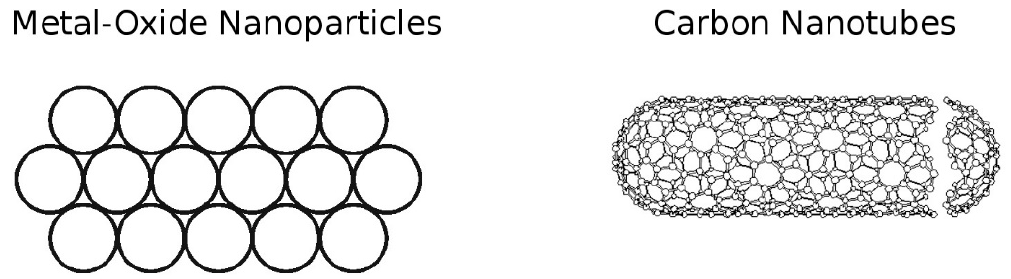
Figure 4. Selected nanomaterials currently being evaluated as functional materials for water purification [97]. (VI) Nanoparticles themselves can form materials with interesting properties for practical use,